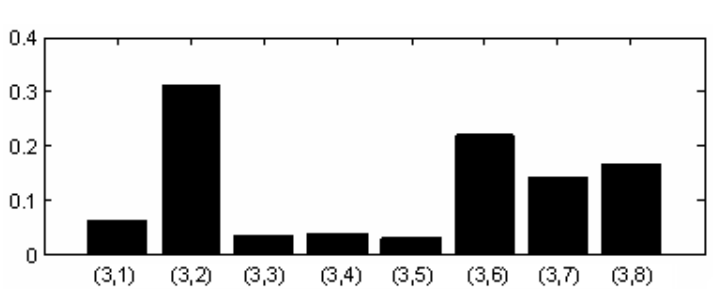
Figure 10. Wavelet packet energy